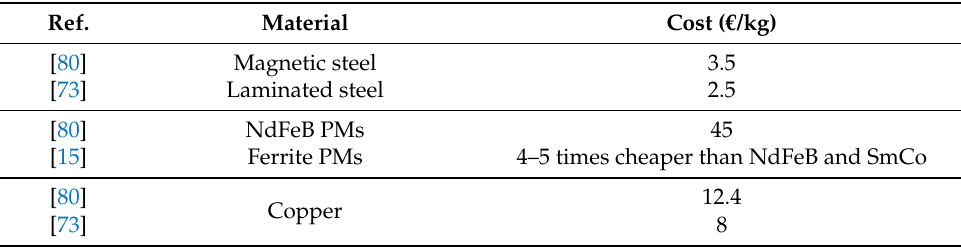
Table 5. Materials